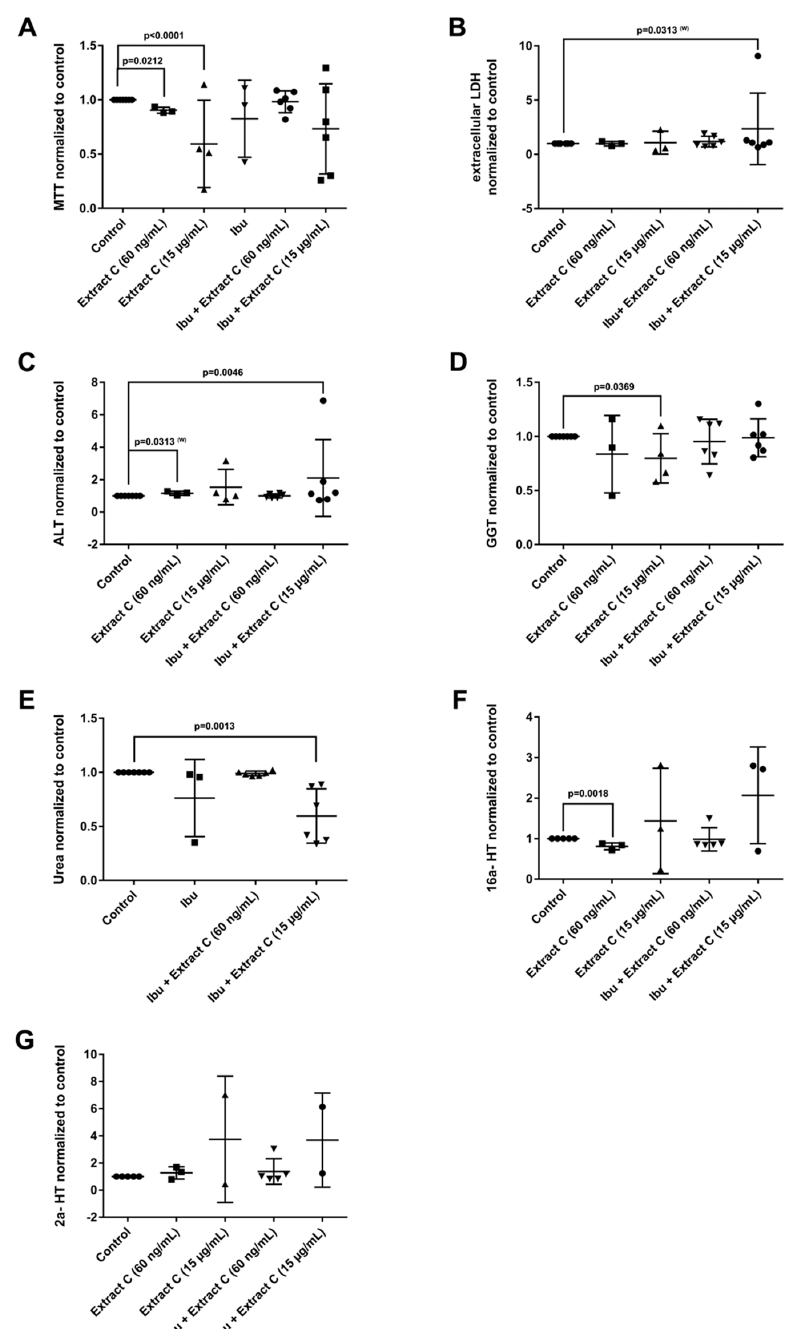
Figure 4. Effects of different Petasites hybridus extracts and Ibuprofen on clinical liver function tests in cultures of human hepatocytes after daily treatment for 72 h. ( A ) MTT mitochondrial reductase activity. ( B ) LDH activity. ( C ) Alanine aminotransferase activity. ( D ) Glutamyltransferase activity. ( E ) Urea production. ( F , G ) Testosterone 16 and 2 hydroxylation activity. The data of individual donors are given normalised to the DMSO vehicle control. The Petasites hybridus extracts A, B and C are specified to 37%, < 1% and 19.1% petasin, respectively. Extract C is the marketed product Petadolex ® and human hepatocyte cultures were treated at therapeutic C max (= 60 ng/mL) and >49-fold therapeutic petasin C max (=15 µg/mL) concentrations. Hepatocyte cultures were also treated with Paracetamol at therapeutic C max (=Para; 20 µg/mL) concentrations and in combinations with different Petasites hybridus extracts. The data were analysed with the GraphPad Prism software version 6.05.